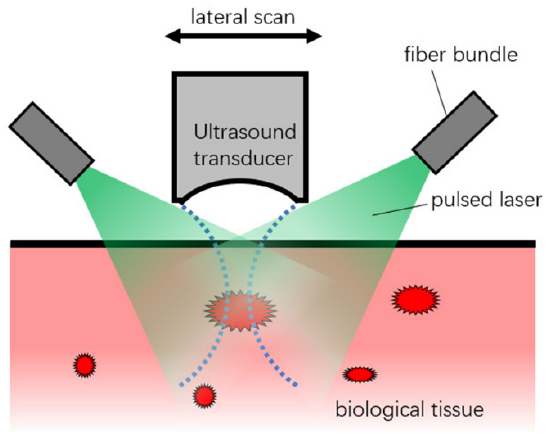
Figure 1. Schematic of AR-PAM scanning.